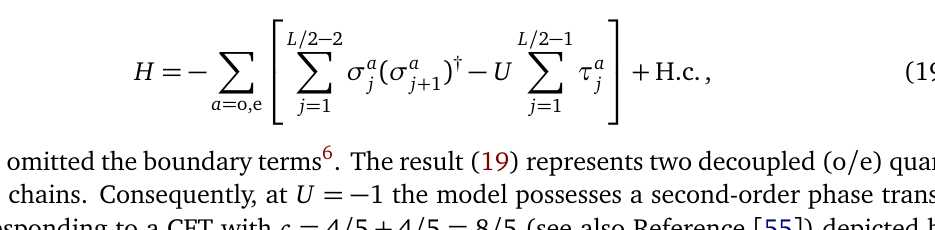
Figure 3: Energy gaps ∆ between the ground state and the n th eigenstate obtained n from finite-size scaling as a function of U for fixed f = 1 + G in Figure 2). In the (cid:90) -ordered phase we observe the three-fold degeneracy of the 2 3 = ∆ = 0) with a finite gap above it ( ∆ ground state ( ∆ 1 2 paramagnetic phase the ground state is unique ( ∆ with the methods discussed in Section 6.1) is located at U very small close to the